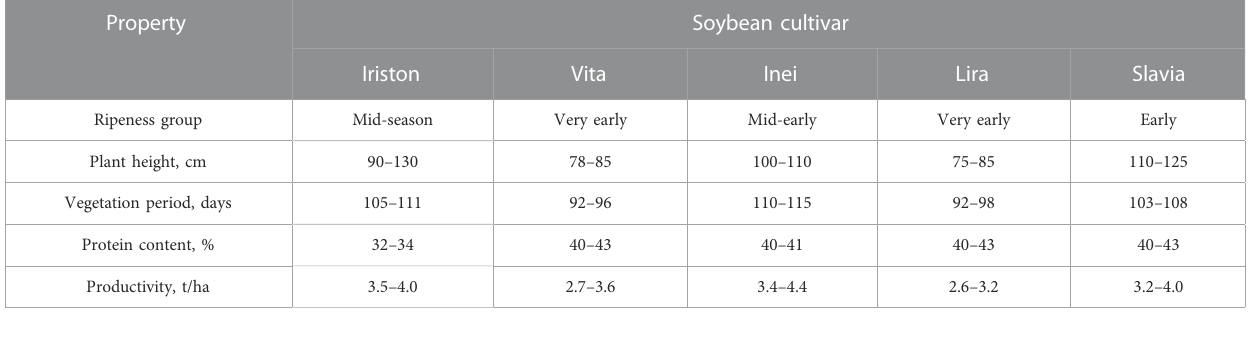
TABLE 1 Main features of the experimental plants. Property